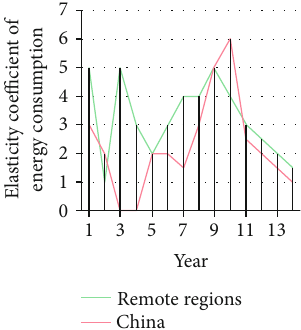
Figure 4: Variation trend of elasticity coe ffi cient of energy consumption in remote areas and